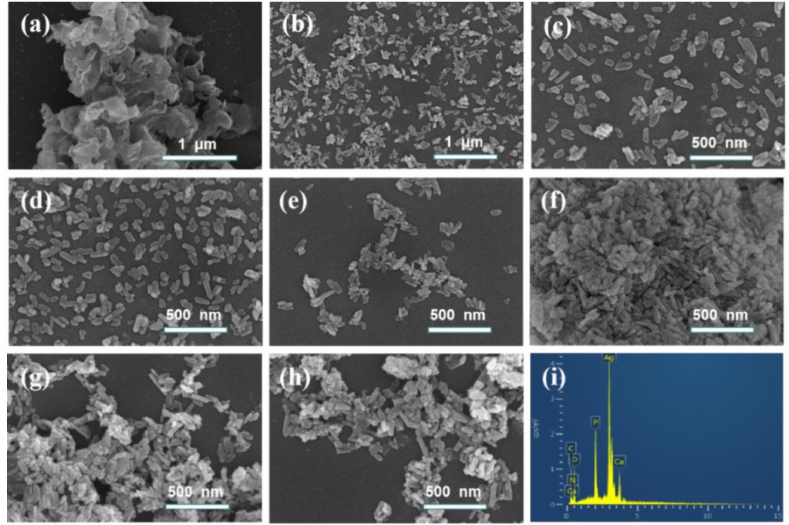
Figure 2. SEM images of ( a ) CN, ( b ) HAP, ( c ) CNH(II), ( d ) CNH(III), ( e ) CNH(IV), ( f ) 3:1-Ag/CNH(II), ( g ) 3:1-Ag/CNH(III), ( h ) 3:1-Ag/CNH(IV), and ( i ) EDS spectrum of